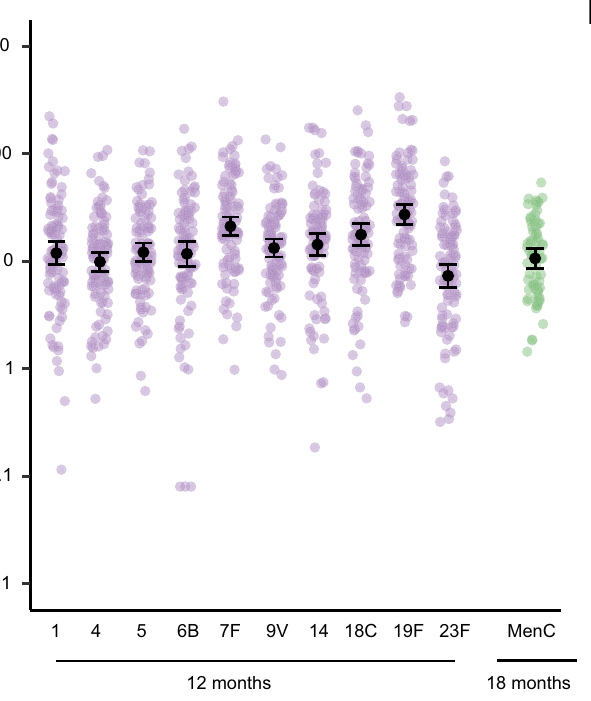
Fig. 1 | Anti-pneumococcal and anti-MenC IgG concentrations following vac- cination. a Immunoglobulin G (IgG) concentrations against 10 pneumococcal vaccine serotypes (1, 4, 5, 6B, 7F, 9V, 14, 18C, 19F, and 23F; n =101) and meningo- coccus type C (MenC; n =66) following vaccination. Black dots and error bars represent geometric mean concentrations with 95% con fi dence intervals (CI).